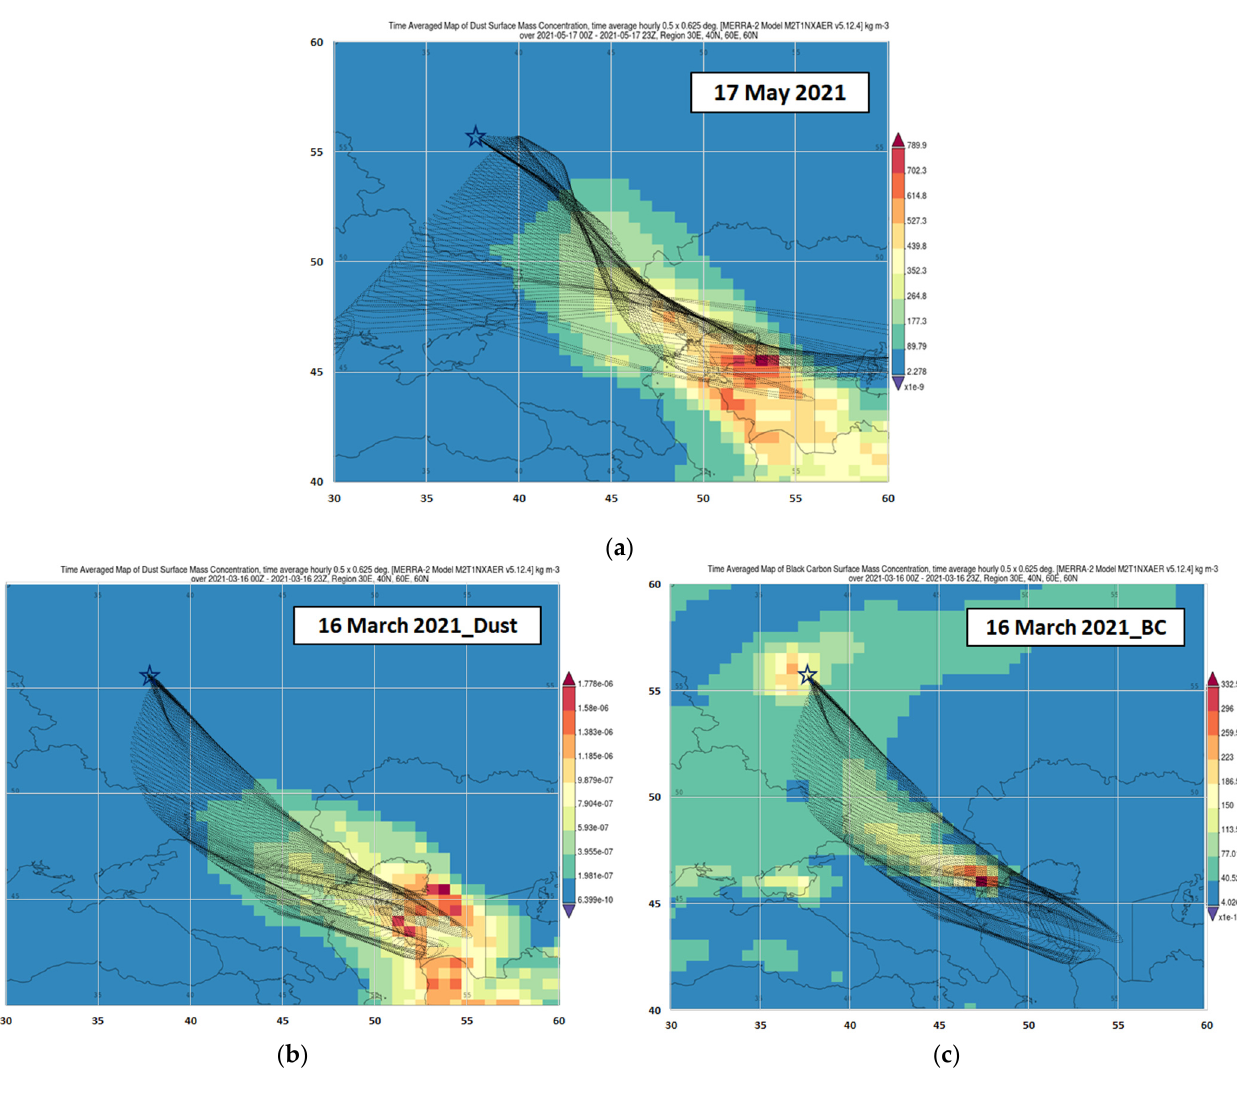
Figure 9. Long-range air mass transport to the Moscow region on 17 May 2021 ( a ) or 16 March 2021 ( b , c ). Distributions of dust ( a , b ) or BC ( c ) in near-surface atmosphere on the maps correspond to the MERRA-2 reanalysis data [81]. The color scales of BC and dust concentrations on the maps are different, kg/m 3 .